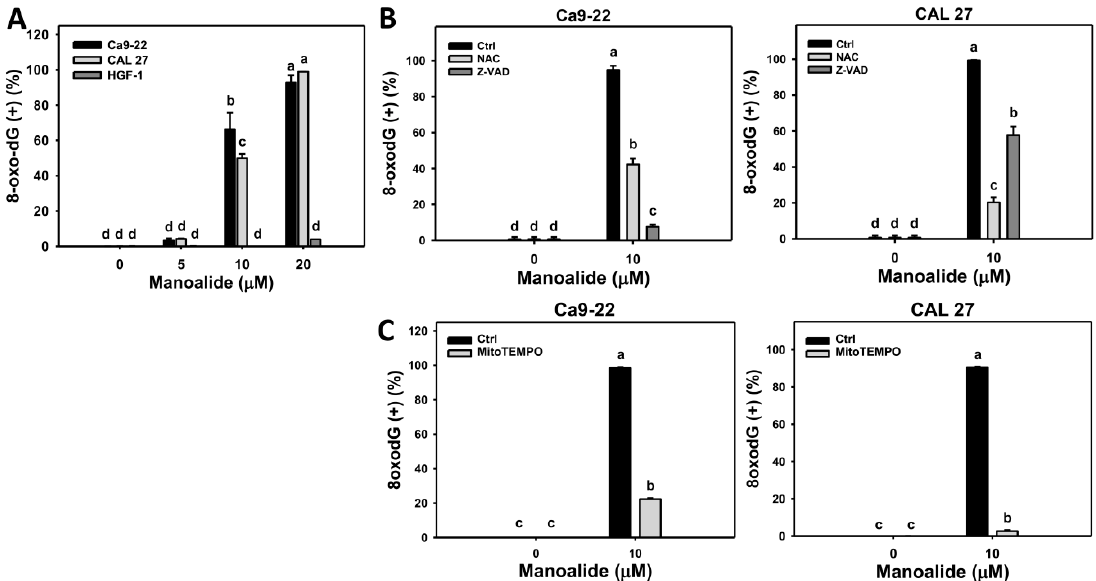
Figure 8. Change of 8-oxodG DNA damage in manoalide-treated oral cancer (Ca9-22 and CAL 27) and normal oral (HGF-1) cells. Cells were treated with the indicated concentrations of manoalide for 24 h. ( A ) Statistical results of 8-oxodG ( + ) (%) for manoalide-treated oral cancer cells in Figure S11A. ( B ) Statistical results of 8-oxodG ( + ) (%) in NAC, Z-VAD, and / or manoalide-treated oral cancer cells in Figure S11B. Cells were pretreated with 8 mM, 1 h for NAC or 100 µ M, 2 h for Z-VAD, and then post-incubated with 10 µ M of manoalide for 24 h. ( C ) Statistical results of 8-oxodG ( + ) (%) in MitoSOX inhibitor (MitoTEMPO) and / or manoalide-treated oral cancer cells in Figure S11C. Cells were pretreated with MitoTEMPO (20 µ M, 1 h) and posttreated with manoalide (10 µ M, 24 h). Data were analyzed by one-way ANOVA with Tukey HSD Post Hoc Test. Data, means ± SDs ( n = 3). Data showing no overlapping same small letters represent significant difference ( p < 0.05–0.001).